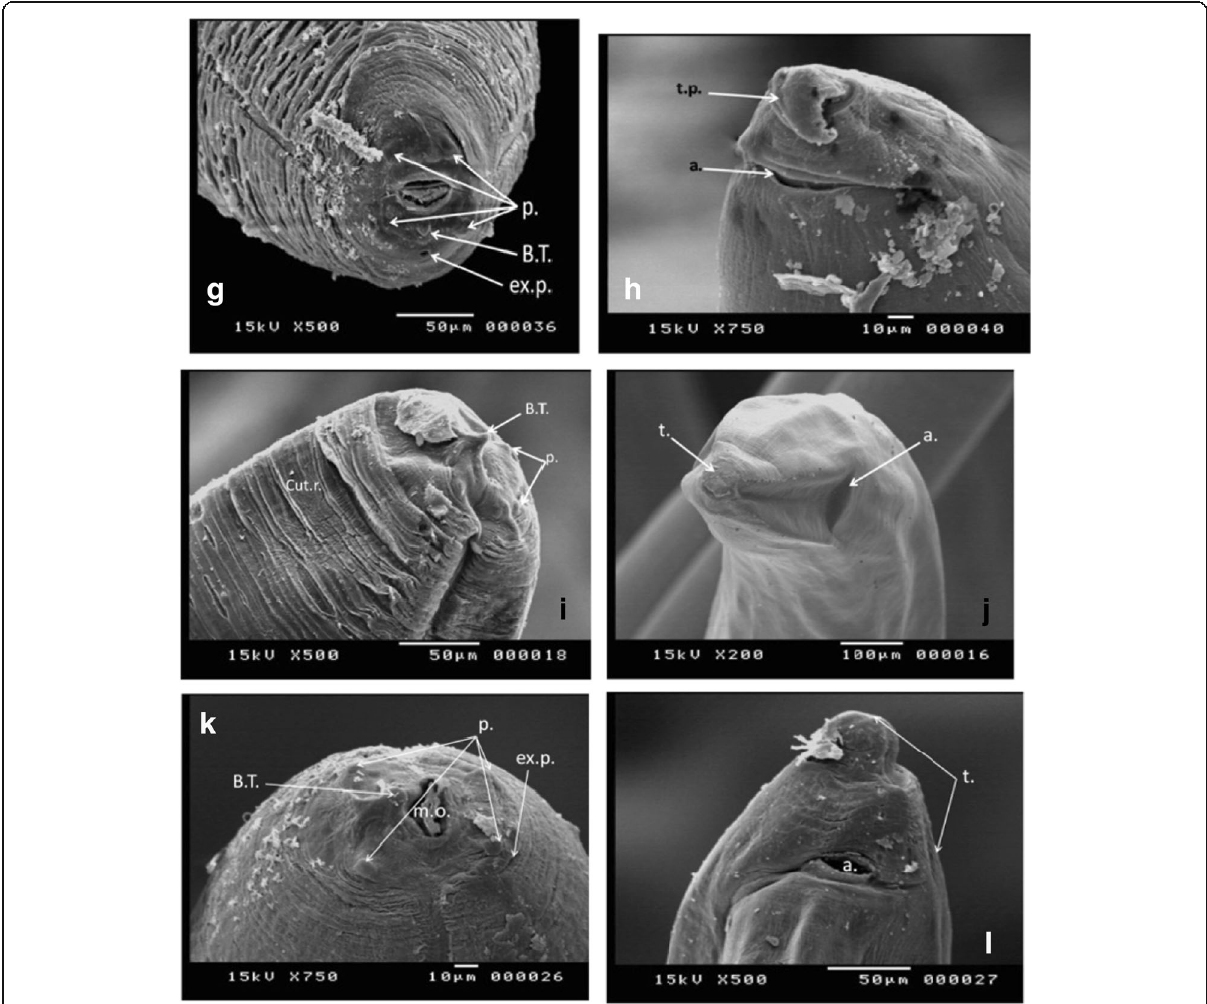
Fig. 3 Scanning electron micrographs: g , h anterior and posterior end of long form larva collected from Lates niloticus ; i , j anterior and posterior end of short form larva collected from Hydrocynus forskahlii ; k , l anterior and posterior end of long form larva collected from Hydrocynus (Fig. 5b, c). Selected amplicons ( n = 28) representing each possible genotype, taking fish species into consideration, were subjected to sequencing. No poly- same SSCP profile.